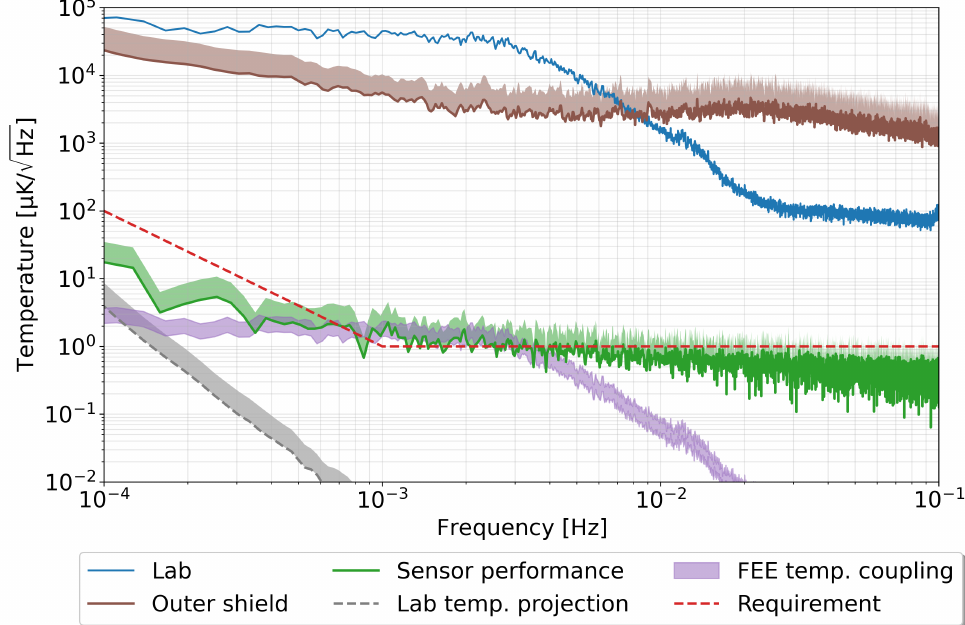
Figure 7. Performance of the temperature measurement system. A sensor attached to the external wall of the vacumm chamber describes the temperature fluctuations in the lab (‘Lab’). The brown curve (‘Outer shield’) shows the mean of the ten sensors attached to the external layer of the three layers composing the thermal shield inside the vacuum chamber. The green curve (‘Sensor perfor- mance’) is the mean of three NTC sensors inside attached to the aluminium core, and the grey curve (‘Lab temperature projection’) shows the noise projection of the outer shield fluctuations inside the aluminium core. The purple area (‘FEE temperature coupling’) shows the estimate corresponding to the coupling of lab temperature fluctuations through the read-out electronics temperature coefficient. Whenever several sensors were used to build the curve, we show the standard deviation of the measurements as a shaded area marking the upper